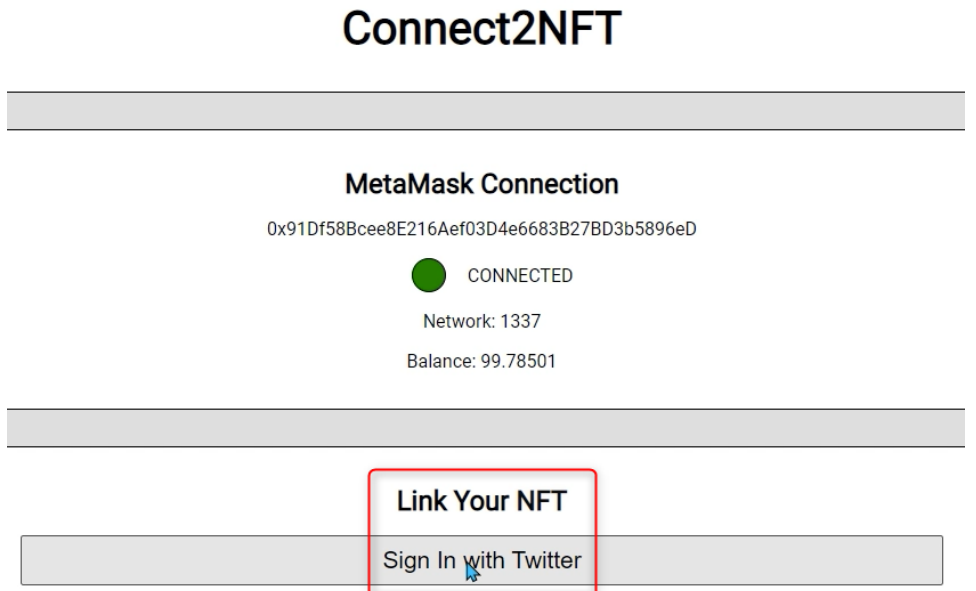
Figure 4. Login attempt to Twitter